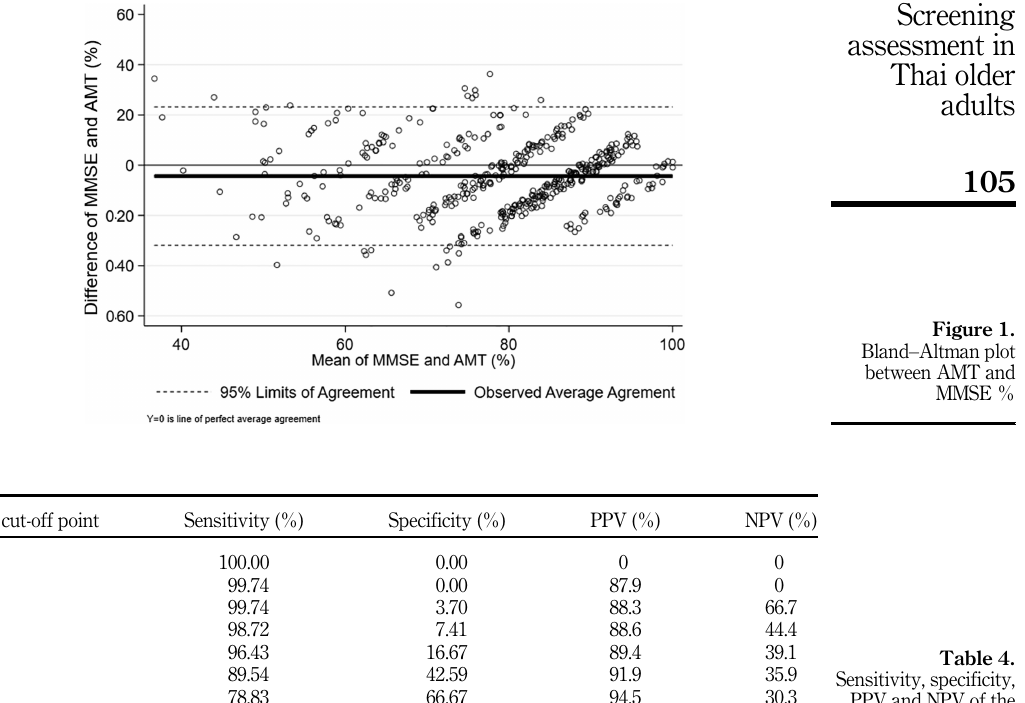
Table 4. Sensitivity, specificity, PPV and NPV of the AMT at different